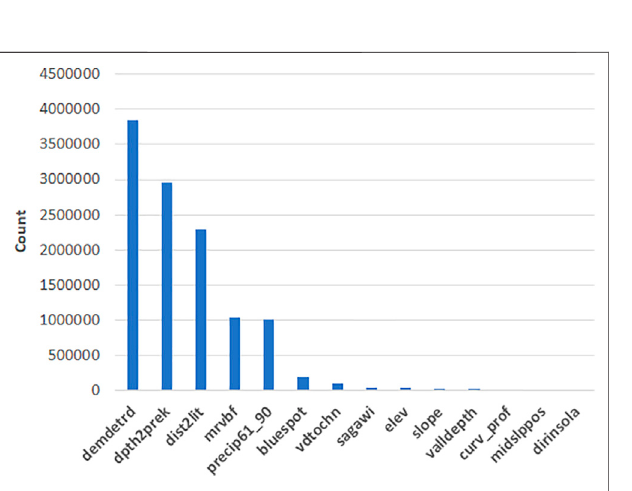
Frontiers in Environmental Science |